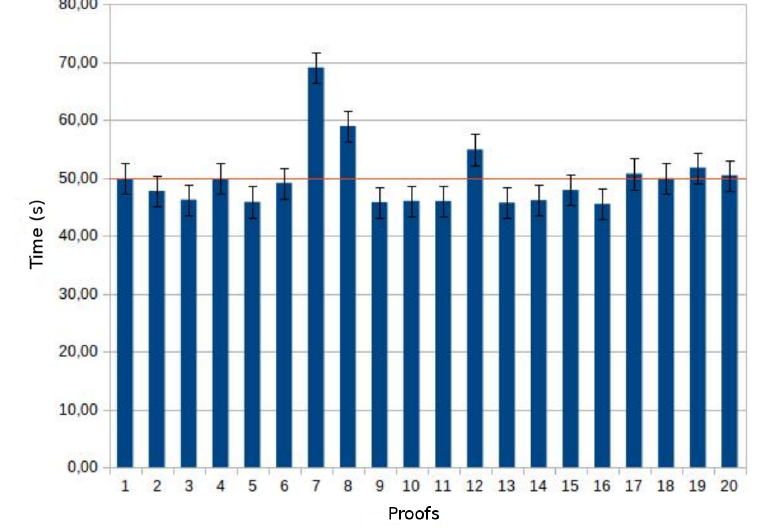
Figure 7. collect action for 5 GB file. 20 proofs average and confidence interval equal to 95%.